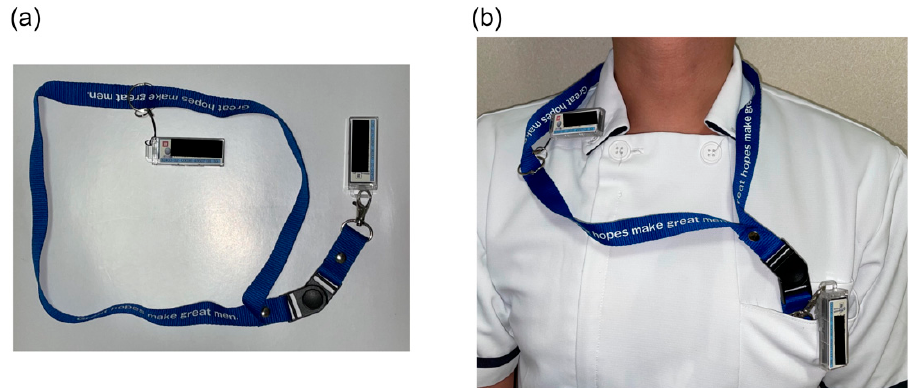
Figure 1. A unique initiative of the surveyed hospital. ( a ) A strap connects both the main and additional dosimeters. ( b ) The use of this strap prevents physicians from forgetting to wear the additional dosimeter.